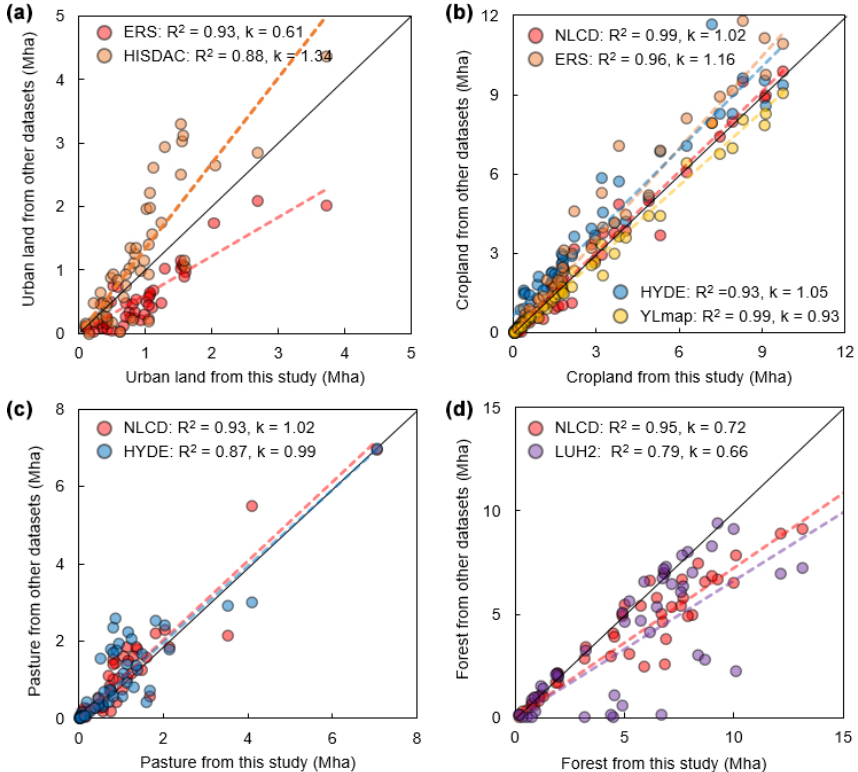
Figure 9. Comparison of the average urban (a) , cropland (b) , pasture (c) , and forest (d) area in each state among National Land Cover Database (NLCD), Historical Settlement Data Compilation (HISDAC), Economic Research Service (ERS), Yu and Lu (2017) cropland (YLmap), History Database of the Global Environment (HYDE), Land Use Harmonization (LUH2), and this study in the overlapping